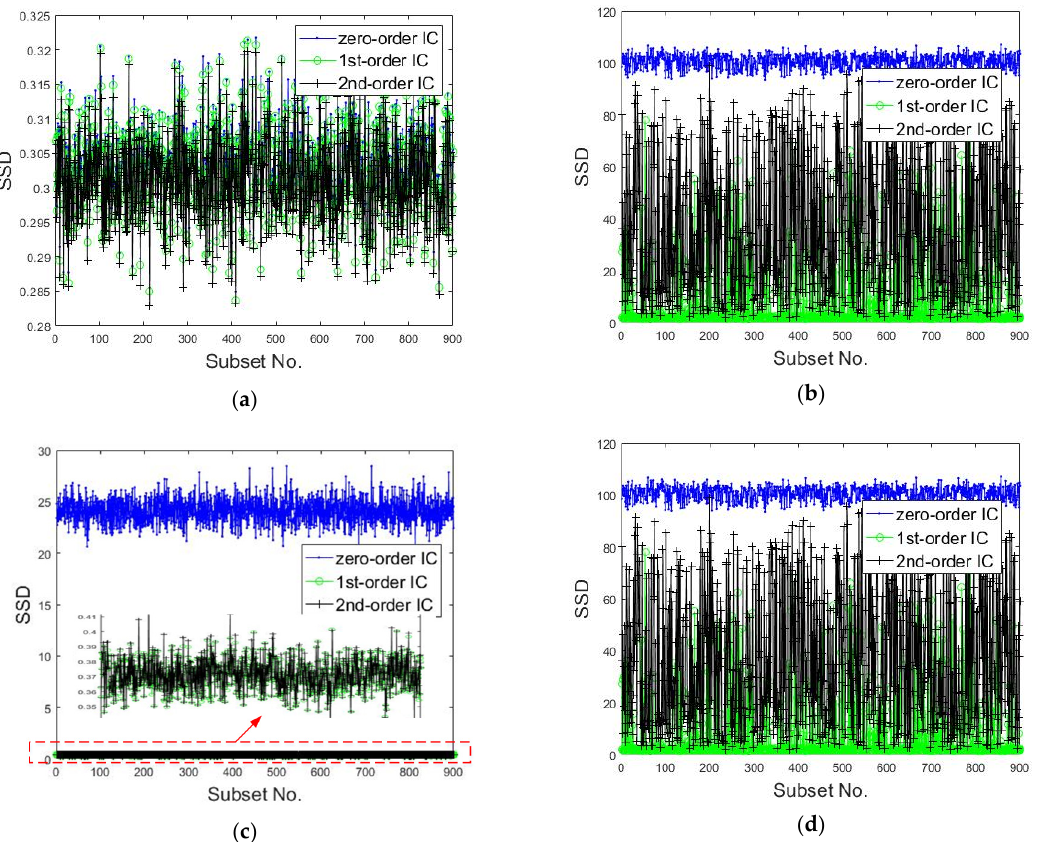
Figure 11. Sums of squared differences (SSDs) between the reference and current subsets calculated by DIC with three kinds of shape functions: ( a ) speckle image of rigid translation, ( b ) speckle image of rigid rotation, ( c ) speckle image of uniform deformation, and ( d ) speckle image of non-uniform deformation.